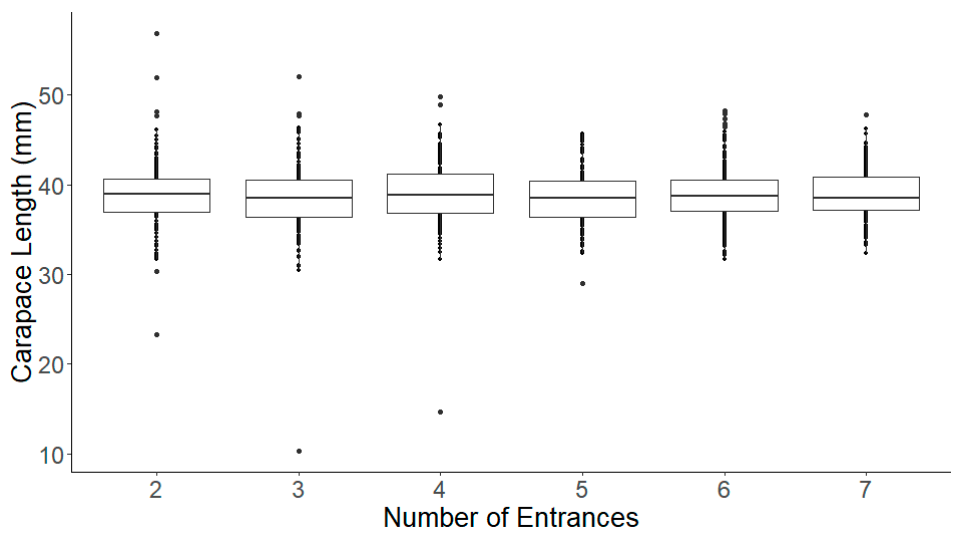
Figure 2. Boxplot of the mean carapace length (mm) of crayfish captured in six traps varying in number of entrances. Horizontal line within each box represents the mean. Lower and upper hinges of the boxes represent the first and third quartile, respectively. Lower and upper whiskers depict scores outside the interquartile range. Black dots correspond to the outliers. Table 1. Summarized regression results for the models presented in Equations (1)–(3). CPUE N represents catch per unit effort by counts. CPUE W is catch per unit effort by weight (g). CL represents carapace length of crayfish in mm.